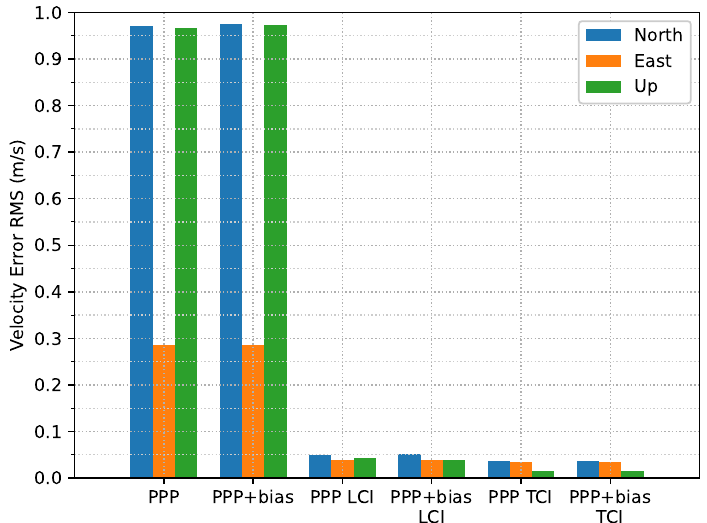
Figure 32. Velocity error RMS of real-time GPS/Galileo PPP/INS positioning of city center test on 27 January 2022 with respect to IE RTK/INS TCI solutions.